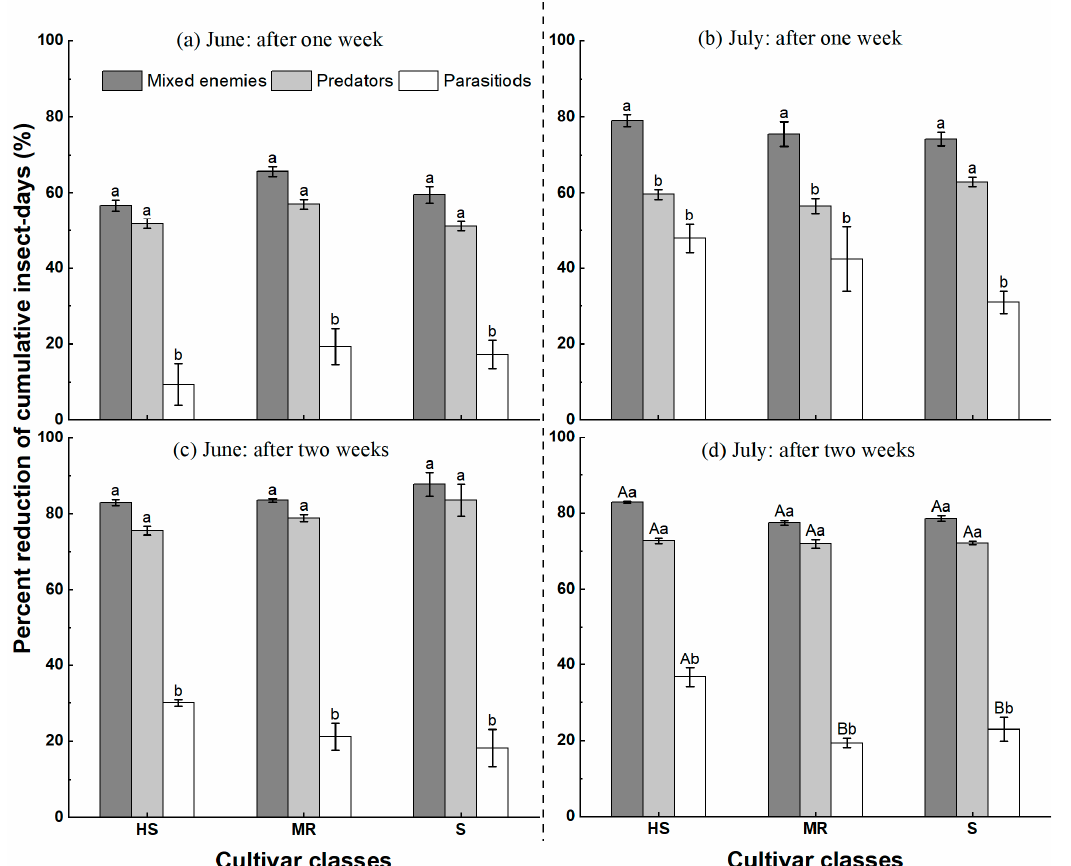
Figure 5. Mean (±SEM) percentage reduction of cumulative insect-days (CIDs) for natural enemies of the pea aphid, Acyrthosiphon pisum , on three cultivar classes (HS = Highly susceptible; MR = Moderate Resistance; S = Susceptible) in a field experiment in Ningxia Province, China, in 2019. Note: The left side of the dashed line represents the period in June after the first harvests, and the right side represents the period in July after the second harvest. Different capital letters indicate significant differences among cultivar classes ( p < 0.05), and different lower-case letters show significant differences among natural enemies ( p < 0.05), mark letters only when they were significant between treatments (HS = Highly susceptible; MR = Moderate Resistance; S =